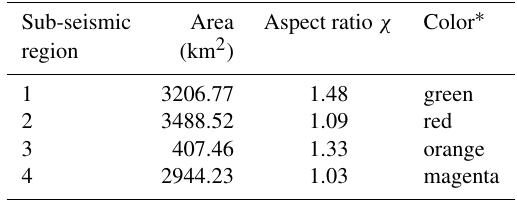
Table 2. Additional data of the sub-seismic regions: area and aspect